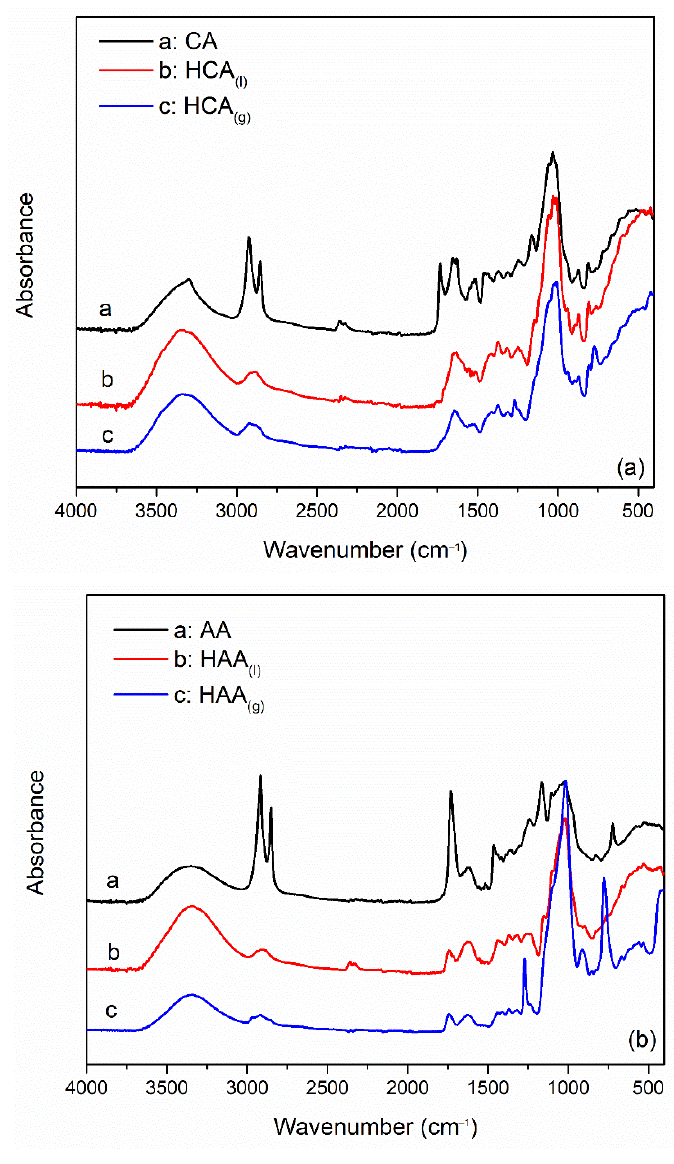
Figure 3. FTIR spectra collected in ATR mode of pristine aerogel (black curves), after LPM silanization (red curves), and after GPM silanization (blue curves). ( a ) CA, HCA (l) and HCA (g) . ( b ) AA, HAA (l) and HAA (g).